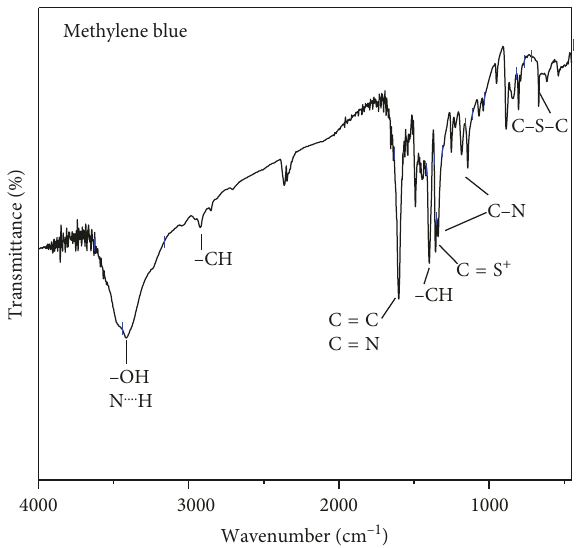
Figure 2: Experimental FTIR spectrum of